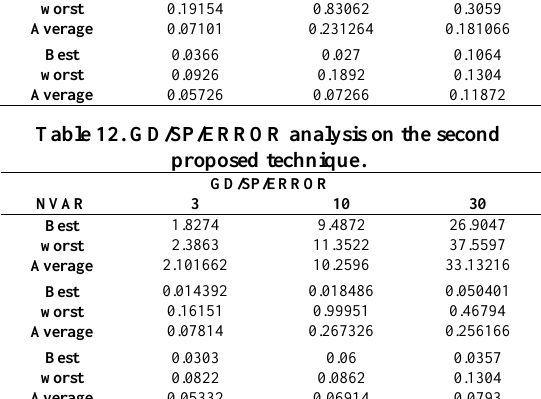
Table 8. GD/SP/ERROR analysis on the first test function. GD/SP/ERROR